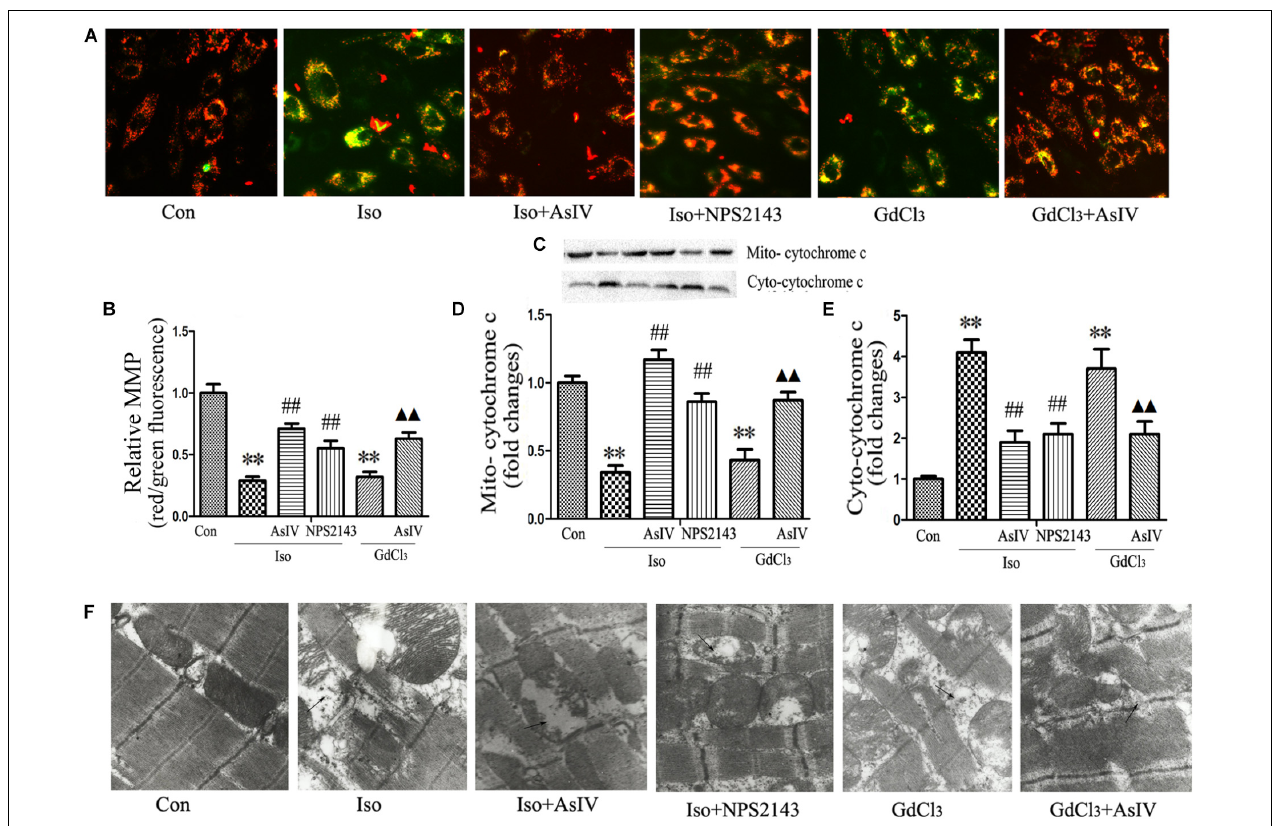
FIGURE 4 | AsIV ameliorated mitochondrial dysfunction in heart tissue and H9C2 cells. (A) H9C2 cells were stained with JC-1, and mitochondrial membrane potential was assessed by fluorescence microscopy. (B) A decreased ratio of red fluorescence to green fluorescence indicates MMP dissipation. (C–E) Mitochondrial and cytoplasmic cytochrome c protein expression assayed by western blot in H9C2 cells. (F) EM was used to detect ultrastructural changes in the left ventricular tissue after the different treatments (magnification × 15,000). The arrows indicate the regions of mitochondrial swelling, cristae breakage, and membrane fusion. The data are expressed as the means ± SEM, n = 4. ∗∗ P < 0.01 vs. the Con group; ## P < 0.01 vs. the Iso group; and (cid:78) P < 0.05, (cid:78)(cid:78) P < 0.01 vs. the GdCl 3